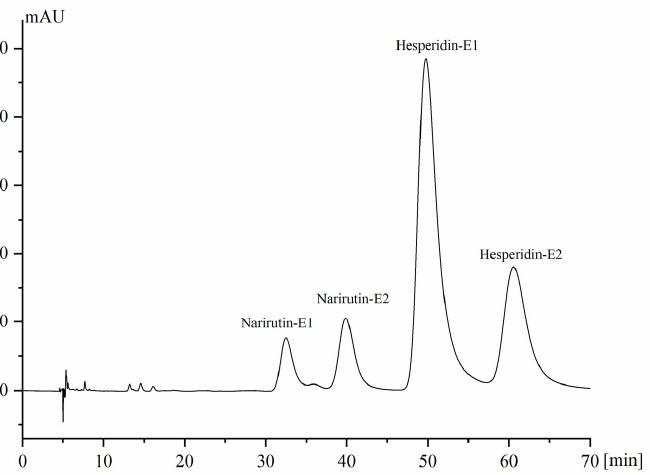
Figure 1. Simultaneous separation of the stereoisomers of hesperidin and narirutin in commercial standard substances under optimized conditions.